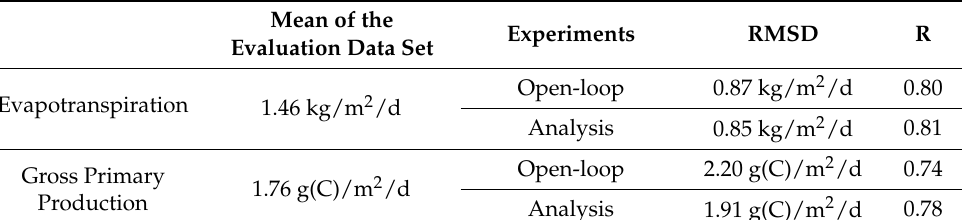
Table 2. Statistical scores from the evaluation of both the open-loop and the analysis with respect to evapotranspiration and gross primary production (GPP) averaged over 2010–2016. RMSD—root mean square difference.